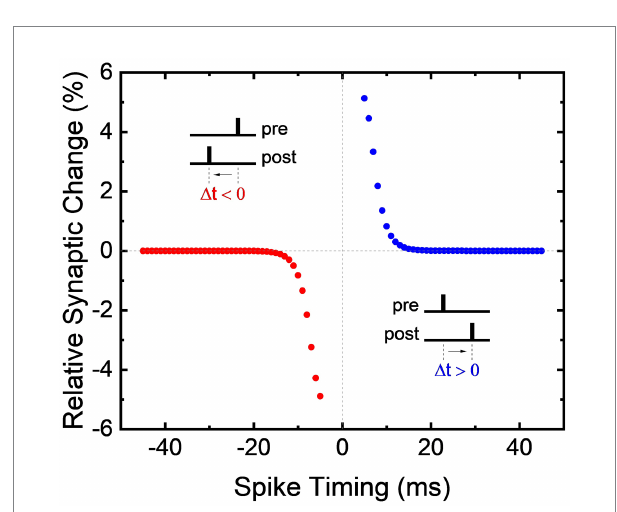
FIGURE 4 Spike-timing-dependent plasticity demonstrated using a bidirectional memristive